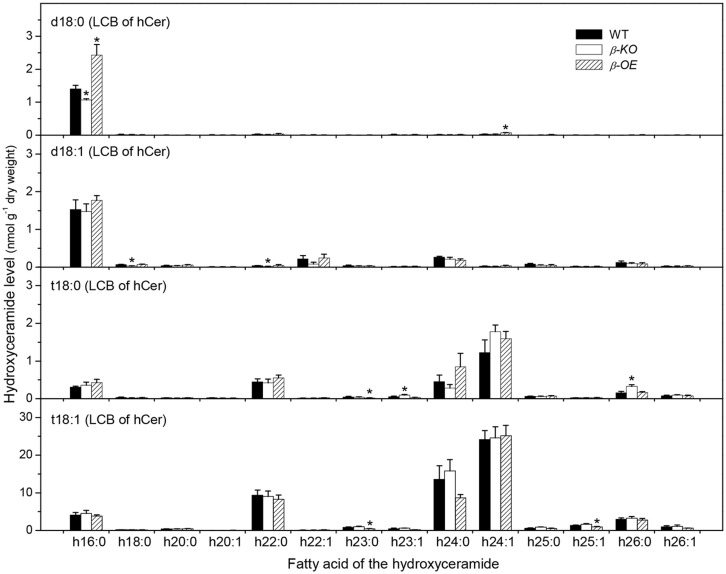
Levels of hCer species in pPLAIIIβ-knockout and overexpression plant leaves. β-KO, T-DNA knockout of pPLAIIIβ (Salk_057212). β-OE, overexpression mutant of pPLAIIIβ driven by cauliflower mosaic 35S promoter. Values are means ± SE (n = 5). *Significant difference at P < 0.05 compared with the WT, based on Student’s t-test.